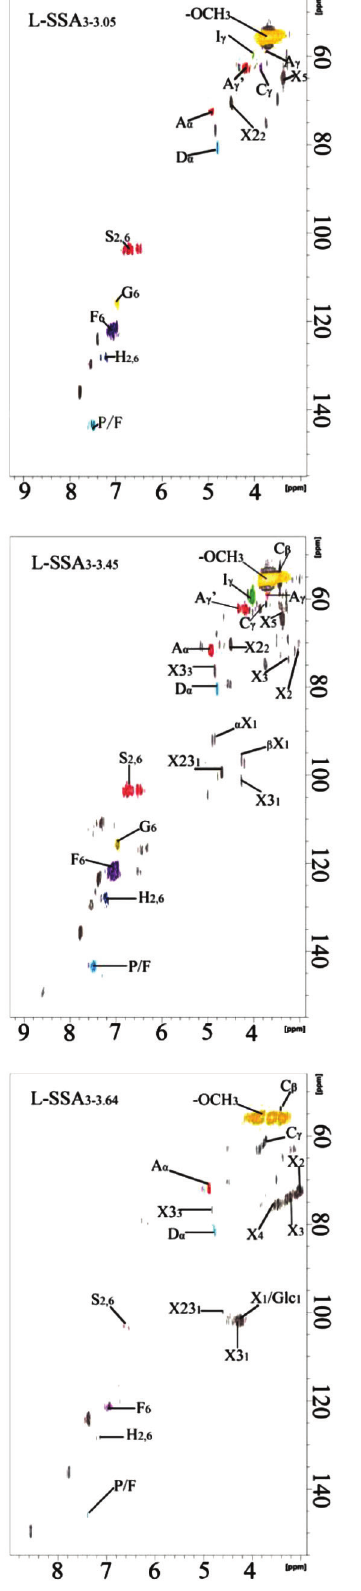
Fig. 1 – 2D HSQc NMR spectrum of l-SSA samples isolated from corncob by different steam explosion severities and sodi- um hydroxide-catalyzed concentrations. l-SSA and L-SSA represent the spectrum of the different operating 3-3.64 conditions.